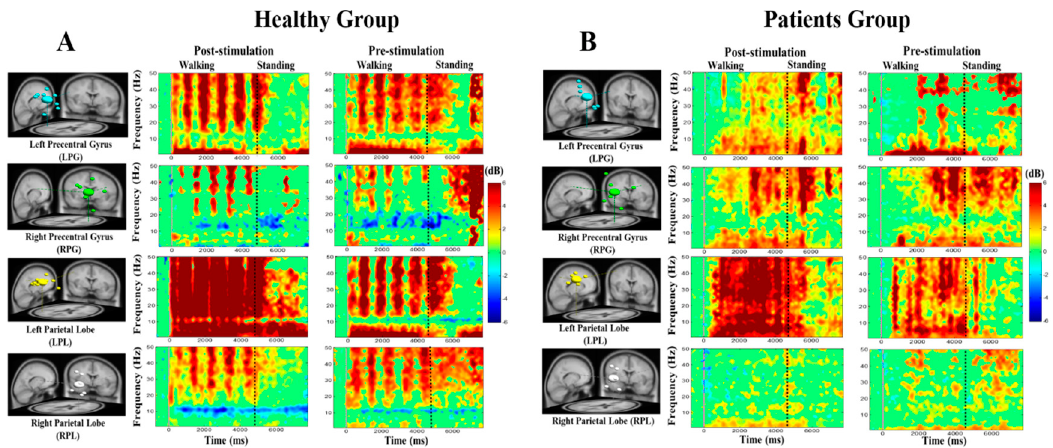
Figure 4. ( A ) The event-related spectral perturbation (ERSP) images of healthy subjects in left and right precentral gyrus (LPG, RPG), and left and right parietal lobe (LPL and RPL) of the brain. ( B ) The ERSP of patients with BVH in LPG, RPG, LPL and RPL of the brain after GVS stimulation. The vertical x-axis reveals the frequency (Hz), horizontal y-axis shows the time (ms), color bars indicate the power (dB) of the ERSPs, in which red indicates significant power increase and green shows power decrease relative to baseline (false discovery rate (FDR)-adjusted, p < 0.05); statistical threshold at p < 0.05. The mu rhythm and alpha power in the LPG, RPG, LPL, and RPL were suppressed during post-